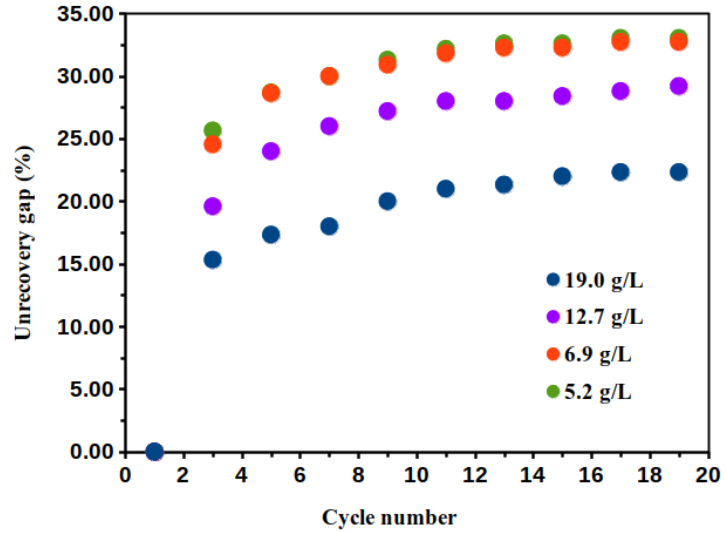
Figure 17. Unrecovered gap as a function of the odd compression cycles (cf. Figure 15) for the different effective concentration 5.2, 6.9, 12.7, and 19.0 g L −1 for APP-E at 1 mol L −1 CaCl 2 .